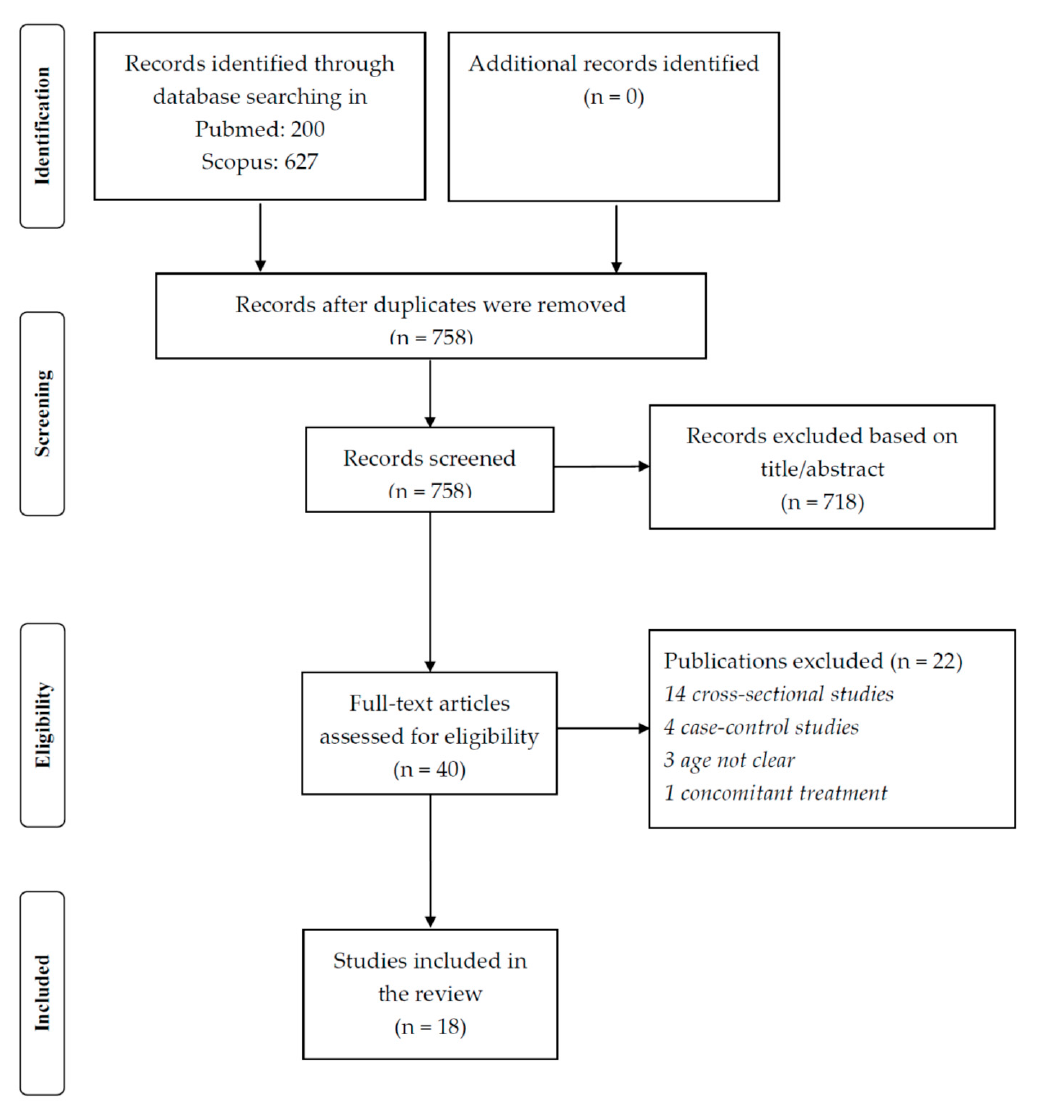
Figure 1. PRISMA flow ‐ chart for the search and study selection.